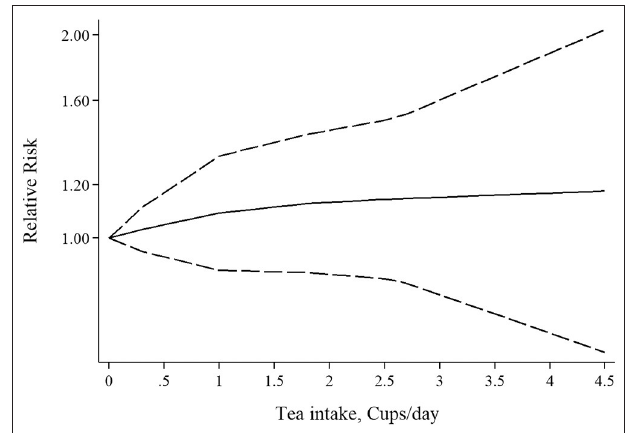
FIGURE 6 | Non-linear dose-response association of tea intake and risk of rheumatoid arthritis.